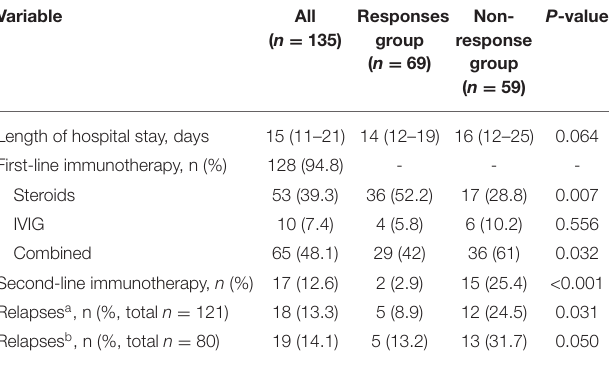
TABLE 3 | Treatment and outcomes of patients with